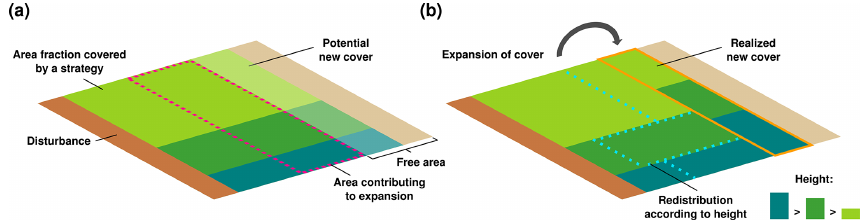
Figure 3. Dynamic surface cover scheme of the LiBry model. The surface cover of a strategy expands due to growth of biomass. The new cover is proportional to the area fraction covered by the strategy, and also to the growth rate of the strategy. For simplicity, the three strategies shown have the same growth rate. (a) Only a part of the cover of a strategy can contribute to the new cover, indicated by the dotted magenta line, the remainder is not able to access the free area for growth. This contributing area decreases proportionally to the available free area. (b) To account for competition between strategies, the contributing area is redistributed according to the height of the strategies. Larger strategies have a higher weight in the redistribution than smaller ones, which represents their competitive advantage. Disturbance reduces the cover of all strategies by a certain fraction at a given time interval, leading to a steady state of cover where expansion is balanced by